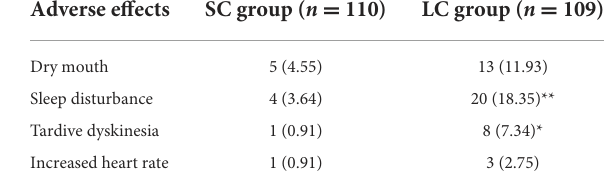
TABLE 4 Adverse effects during